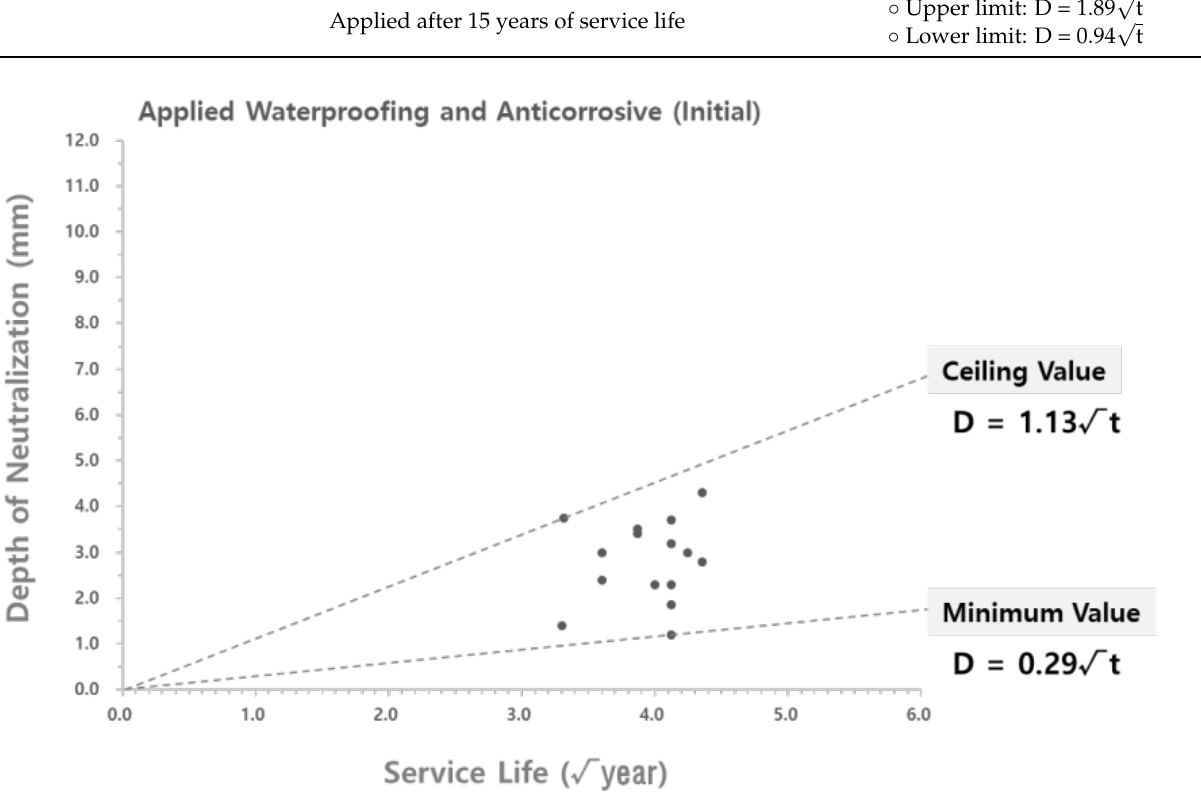
Figure 7. Carbonation depth distribution on the inner wall of the water reservoirs (waterproof- ing/anticorrosive method applied after 10 years of service life) - reflect on-site adjustments 3.2.5. Derivation and Comparison of Carbonation Rate Coefficients of Water Reservoirs with No Waterproofing/Anticorrosive Method Applied after Public Service The derivation of the carbonation rate coefficient of the water reservoirs with no waterproofing/anticorrosive method applied after public use follows the steps shown in Figure 8. In order to derive the carbonation depth at